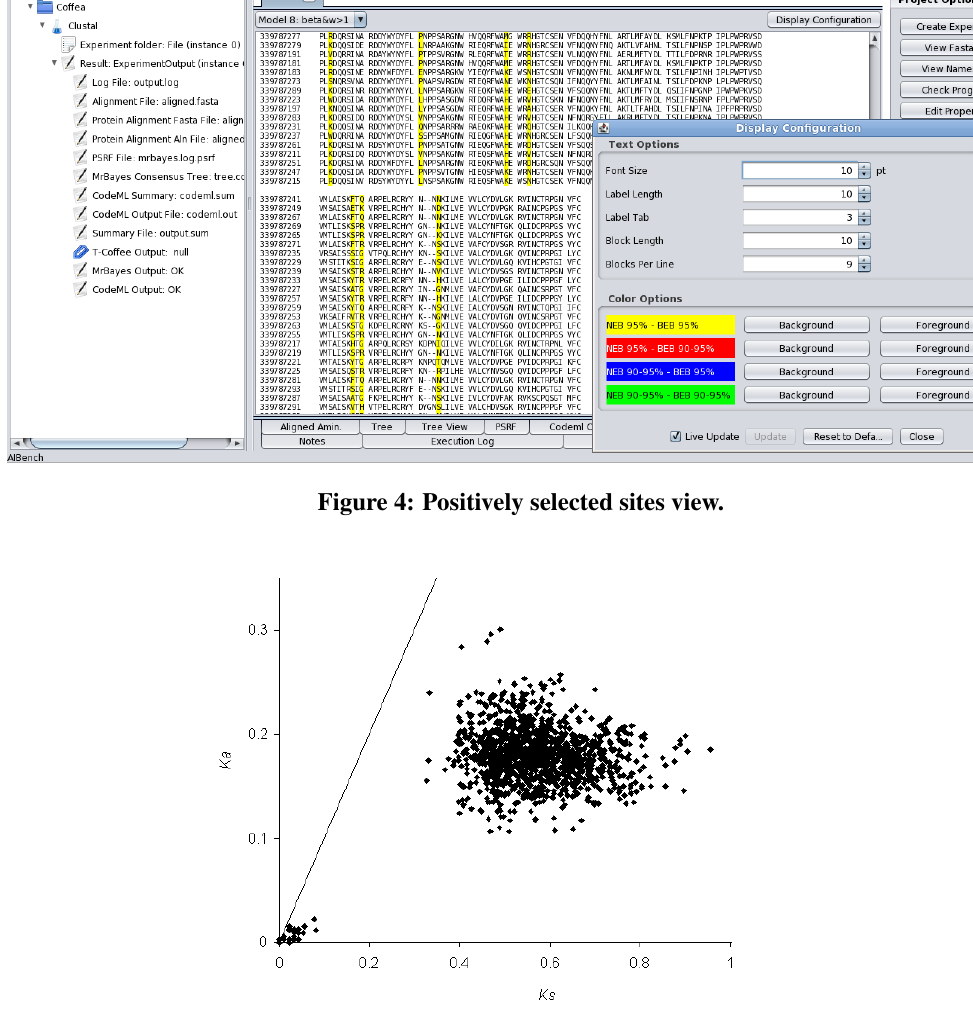
Figure 5: Coffea S-RNase Ka/Ks scatter